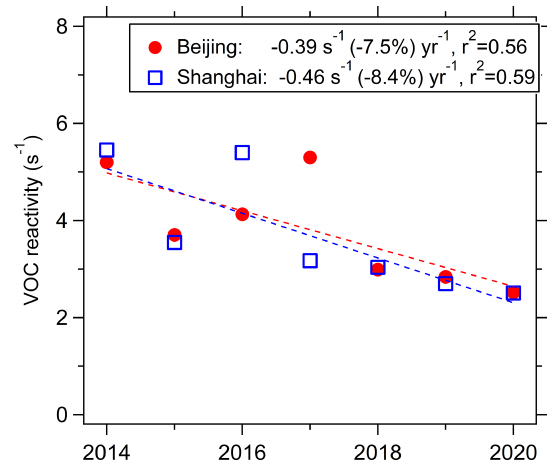
Figure 8. Variations in averages of daytime VOC reactivity in Bei- jing and Shanghai, during summertime of